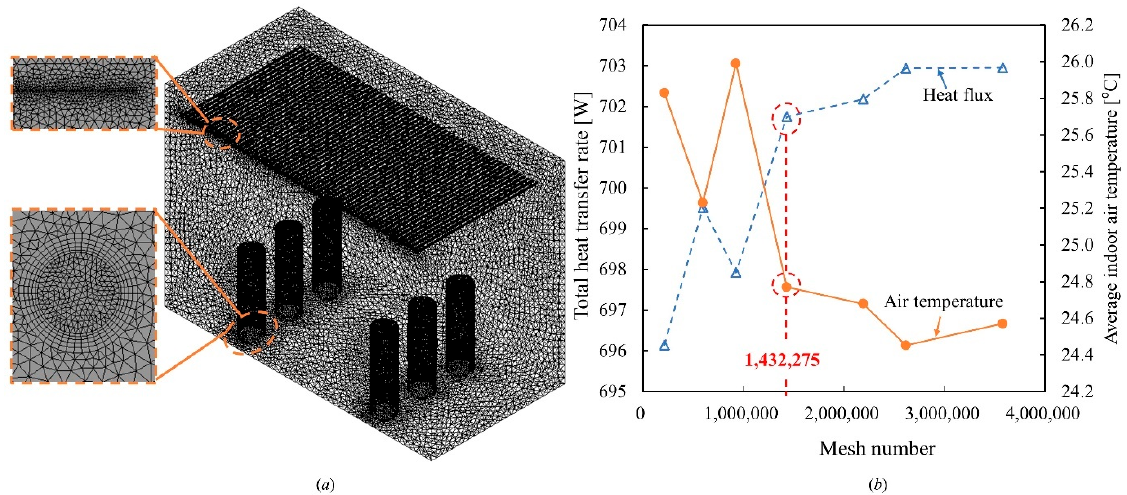
Figure 3. ( a ) Computational mesh used in the present study. ( b ) Mesh-independent analysis re- sults.